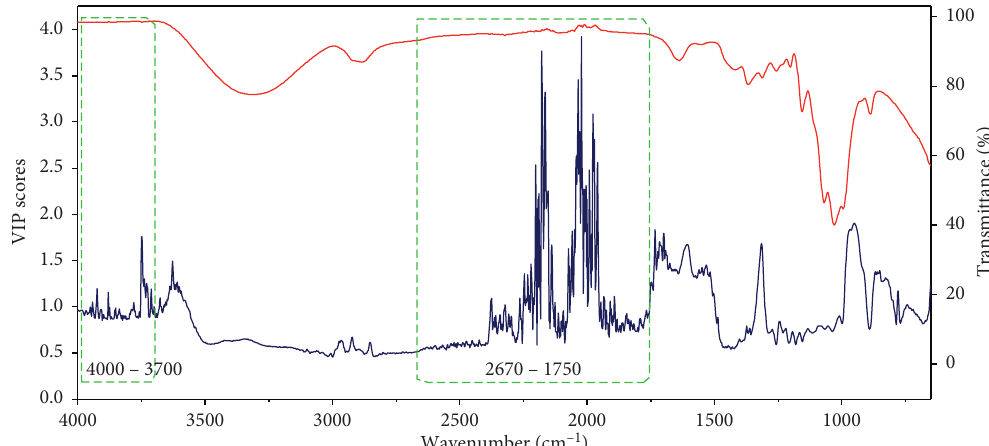
Figure 3: The VIP scores (dark line) extracted from the PLS-DA model of FTIR data of wild samples, appended with the instrumental signal recorded on a sample (red line). the variables in green rectangle areas are chosen to delete.